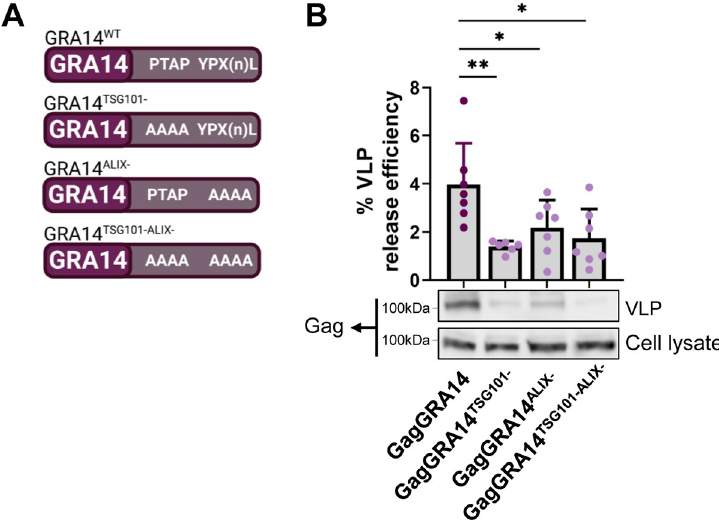
Fig 7. Late domain motifs encoded in TgGRA14 C-terminus can mediate ESCRT-dependent HIV virus-like particle release. A. Schematic of the generation of mutants in the late domain motifs PTAP and YPX (n) L encoded by TgGRA14. B. Analysis of virus-like particle release by GagGRA14 and GagGRA14 mutants. Representative immunoblots of VLP release include top: VLP release sample (100%) and bottom: cellular lysate sample (4%). Data represents the mean from � 6 biological replicates. Statistical analysis was by Student’s t-test. Only statistical differences are shown. � p < 0.05, �� p < 0.01, ��� p < 0.001.